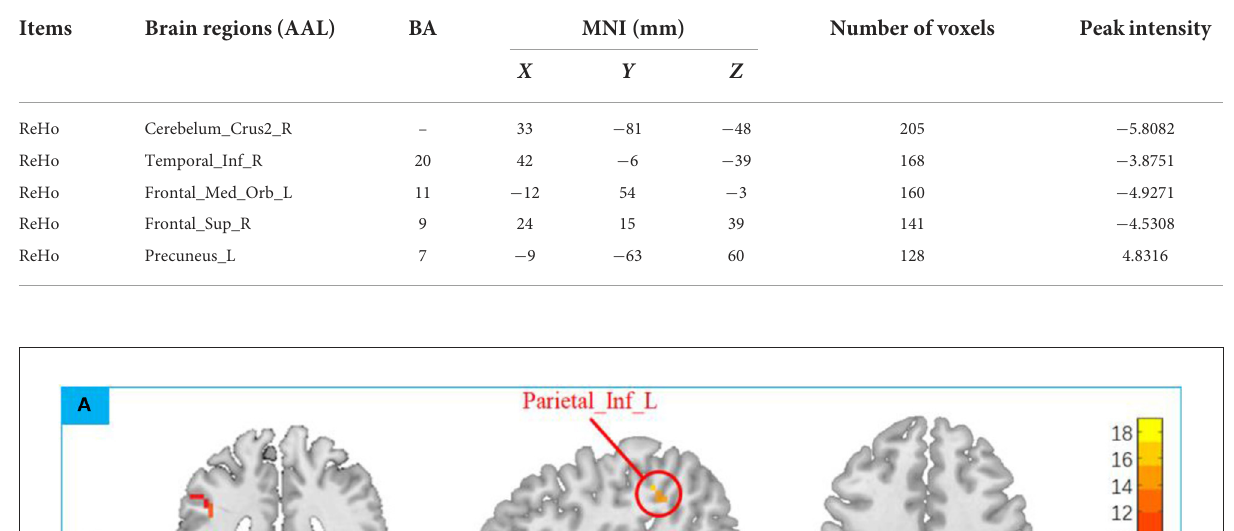
TABLE 4 Anatomical Locations of Significant Main Effect of Group on ReHo.